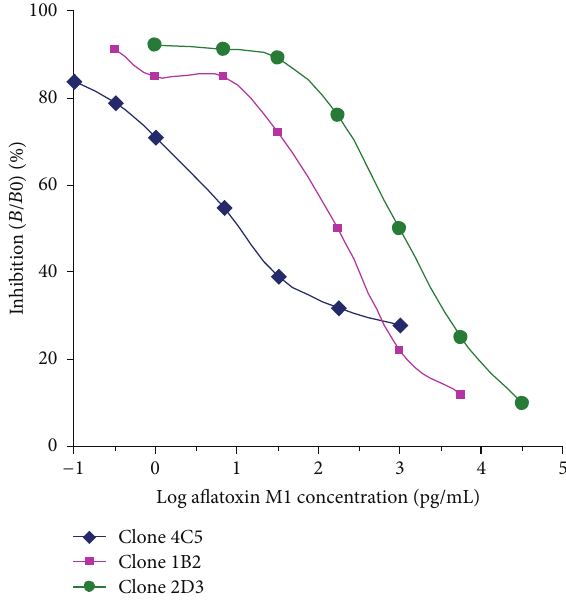
Figure 6: Cross-reactivity of three McAbs to aflatoxin